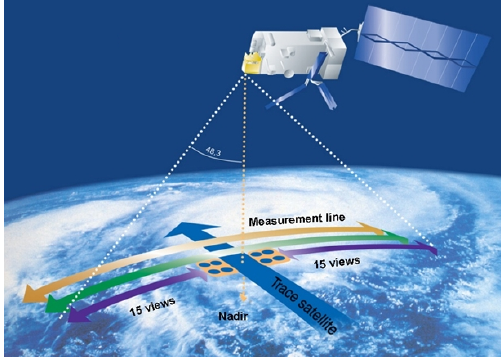
Figure 2. Modus operandi of IASI instrument. The instrument scans the Earth’s surface at regular intervals producing 30 FORs per line. Each FOR consists of 4 IFOVs, each of which represents a full spectrum.